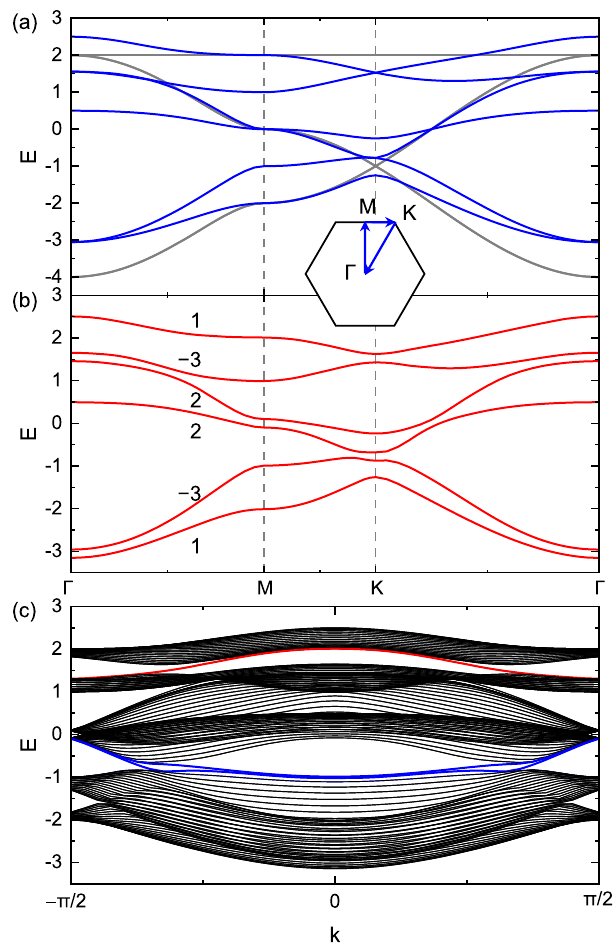
Fig. 2 Dispersion relations of the non-interacting model. Bulk dispersion relations without the spin-orbit coupling (SOC) ( a ) and with the SOC λ = 0.2 ( b ). In both cases, energy E is scaled by the π -bond hopping integral t δ -bond hopping integral π . Gray lines in a indicate the dispersion with the t δ = 1, which realizes the ideal dispersion in a kagome lattice. Blue lines in ( a ) and red lines in ( b ) are dispersions with t δ = 0.5. The inset shows the fi rst Brillouin zone with high-symmetry lines used in ( a ), ( b ). The Chern number C n for the spin up component of each band is also shown in ( b ). c Dispersion relations with t δ = 0.5 and λ = 0.2 in the ribbon geometry, which is periodic along the a 1 direction and contains 20 unit cells along the perpendicular direction. Gapless edge modes are indicated by red and blue